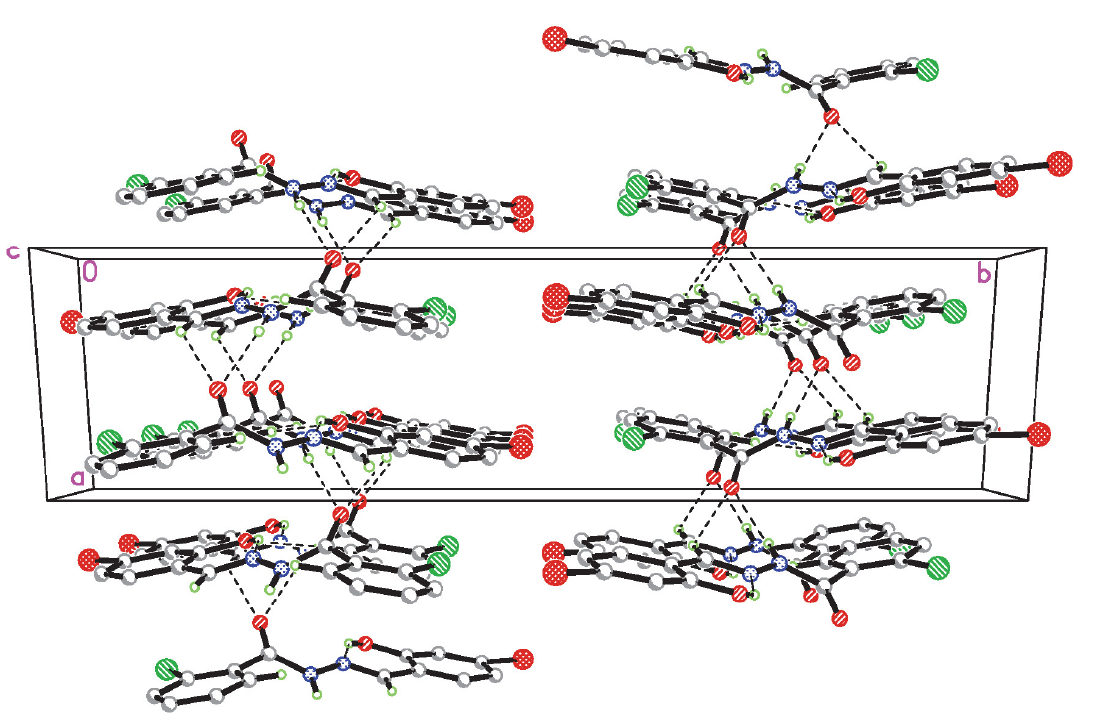
Figure 2. Molecular packing structure of H 2 L 1 , with hydrogen bonds shown as dotted lines.